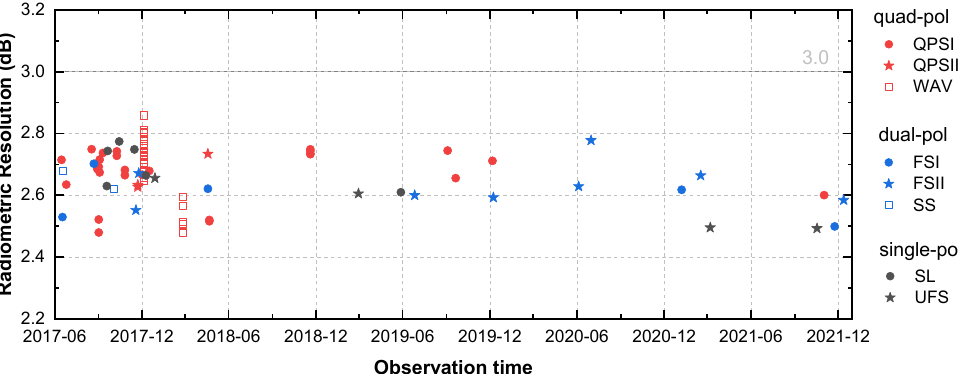
Figure 4. GaoFen-3’s radiometric resolution assessment based on single-pol, dual-pol, and quad-pol strip datasets, which were acquired from the Amazon rainforest from June 2017 to December 2021. The results are summarized for all imaging modes from the data with the same orbit and beam code on the same day. Red represents the results of three different quad-pol modes, QPSI, QPSII, and WAV; blue represents the results of the FSI, FSII, and SS modes; and black represents the results of the SL and UFS modes.